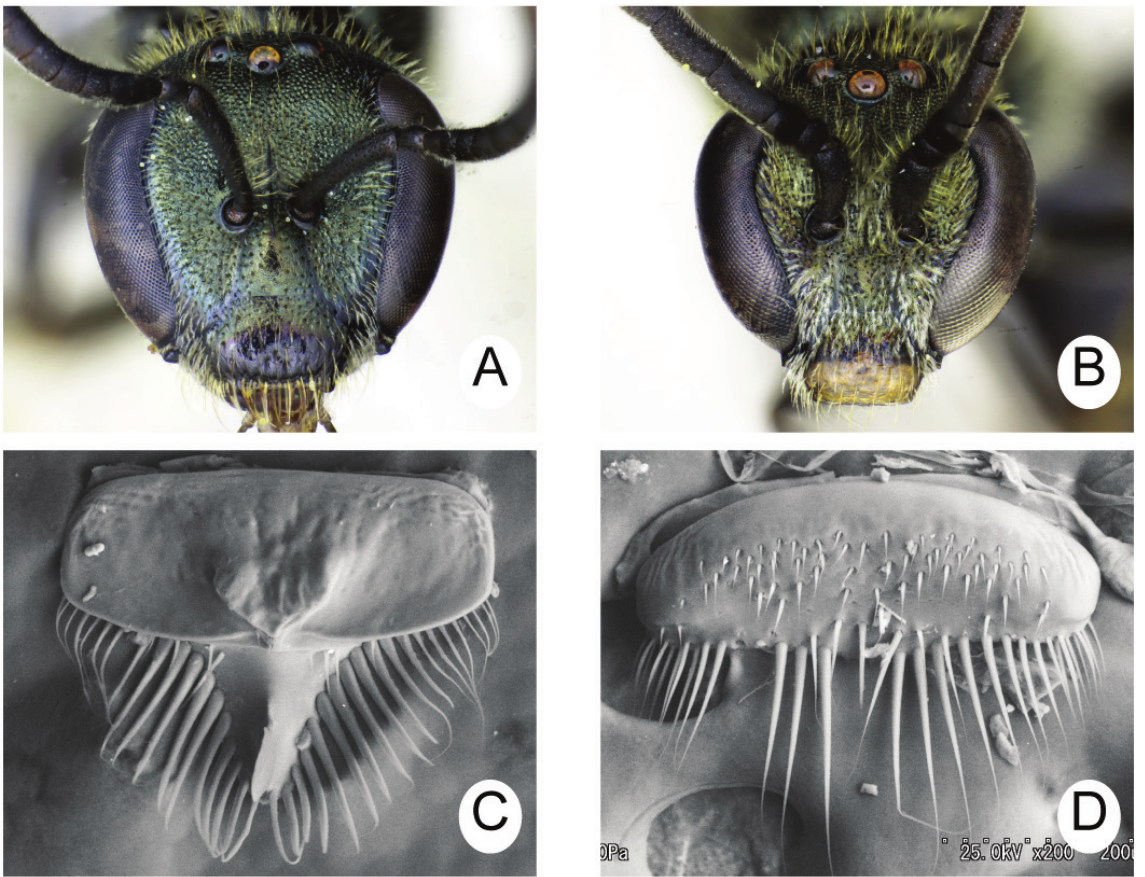
Fig. 8. Lasioglossum ( Dialictus ) virideglaucum ebmer & Sakagami, 1994. A–B . head in frontal view. C–D . Labrum. A, C. ♀. B, D.